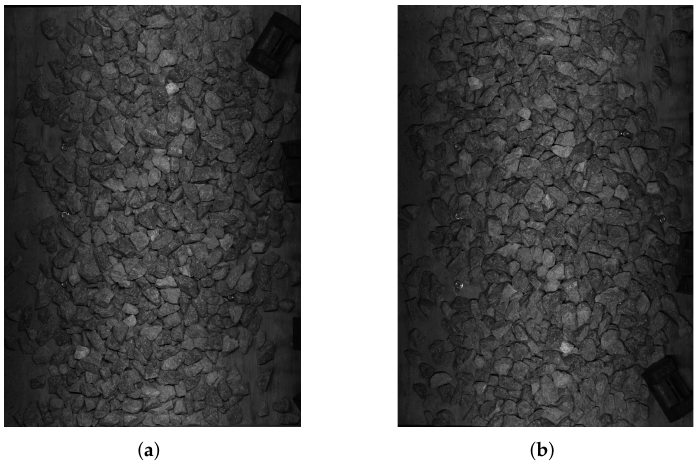
Figure 1. Image of ore in a real-world working situation. ( a ) Example 1. ( b ) Example